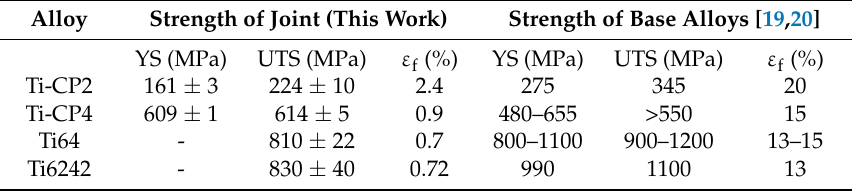
Figure 5. ( a ) Typical stress-strain curves of the joints, ( b ) tensile strength σ max and elongation at fracture ε f of the joints. An average from three test specimens is presented. Table 3. Comparison of strengths of brazing joints and strength of base material [19,20].